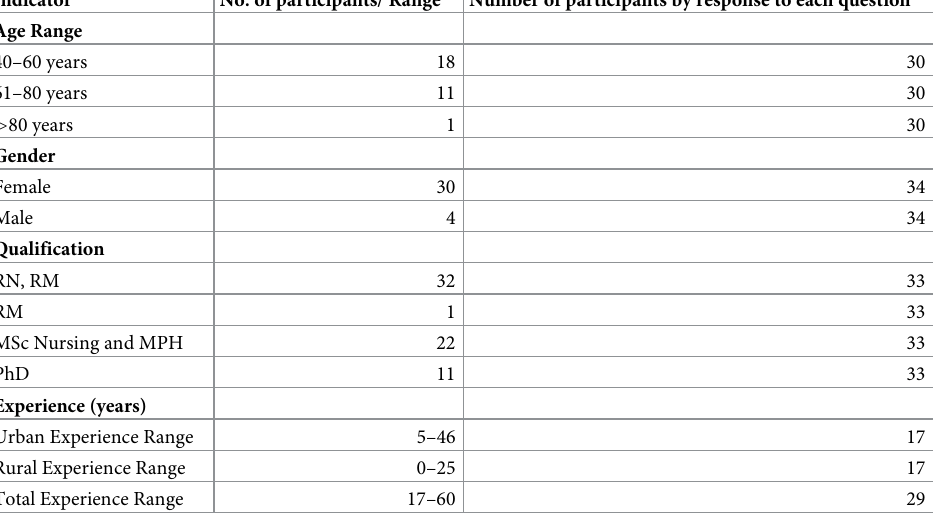
Table 1. Participant